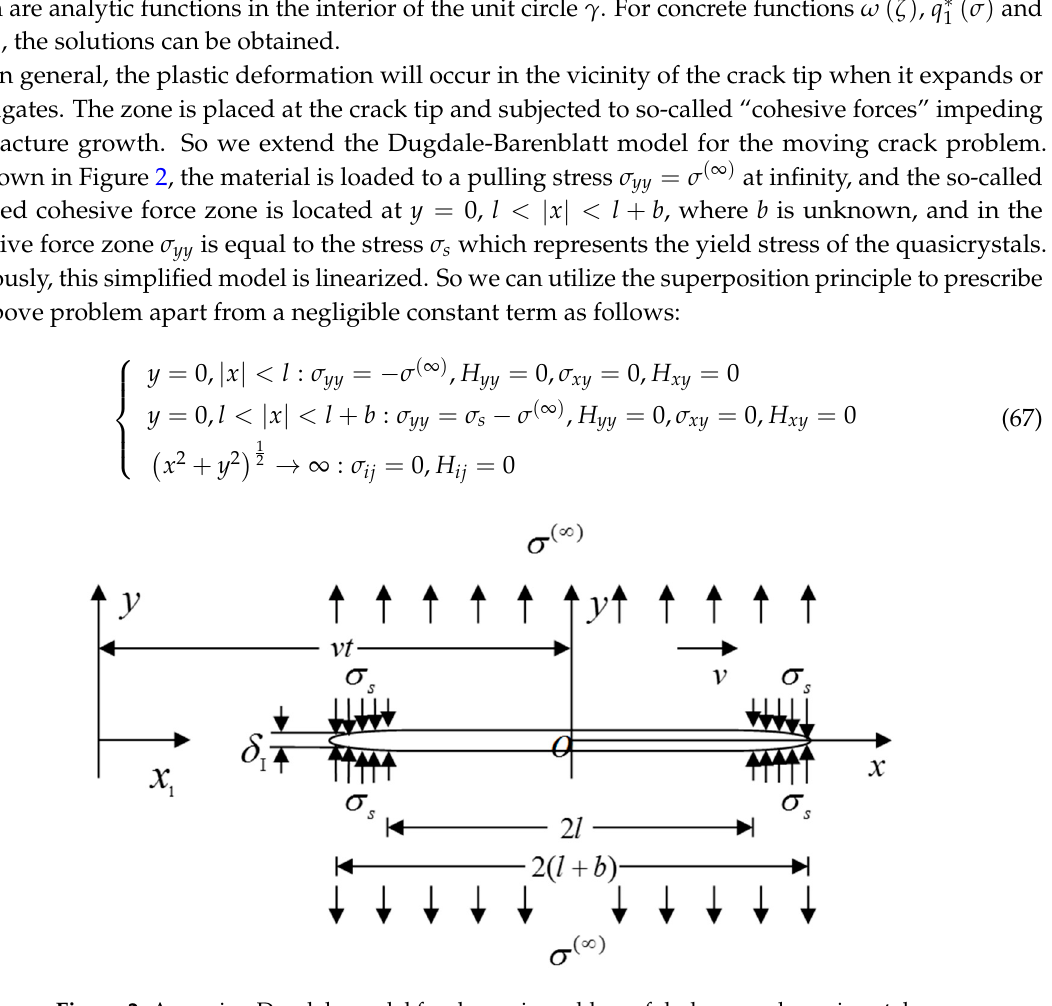
Figure 2. A moving Dugdale model for dynamic problem of dodecagonal quasicrystals.